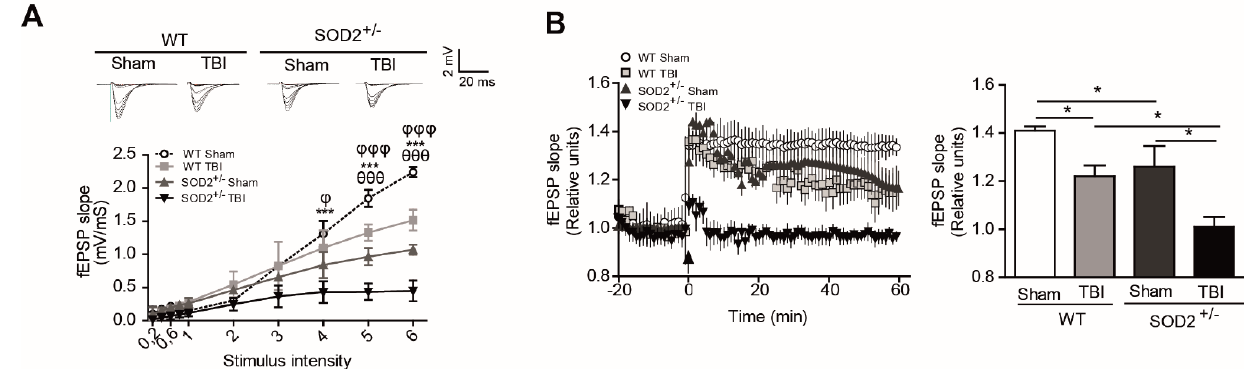
Figure 3. WT and SOD2 +/ − mice show synaptic failure and synaptic plasticity impairment in the hippocampal circuit after TBI. ( A ). fEPSP slope induced by the input-output protocol to record total responses from WT and SOD2 +/ − mice after TBI. ( B ). LTP was generated by HFS in the hippocampal CA1 area in slices from WT and SOD +/ − mice after TBI. Quantification of fEPSP slope 60 min after HFS. Data are means ± S.E. Three animals were used per experimental group. 3–4 hippocampal slices per animal were analyzed. Statistically significant differences were calculated by one-way or two-way ANOVA and, followed by Bonferroni’s post hoc test. Symbols indicate the statistical significance of the observed differences. (Figure 3A: θθθ p < 0.001; between WT Sham and WT TBI; ϕ p < 0.05, ϕϕϕ p < 0.001 between SOD2 +/ − Sham and SOD2 +/ − TBI; *** p < 0.001 between WT TBI and SOD2 +/ − TBI. Figure 3B: * p < 0.05). (LTP, Long- term potentiation; fEPSP, field excitatory postsynaptic potential).